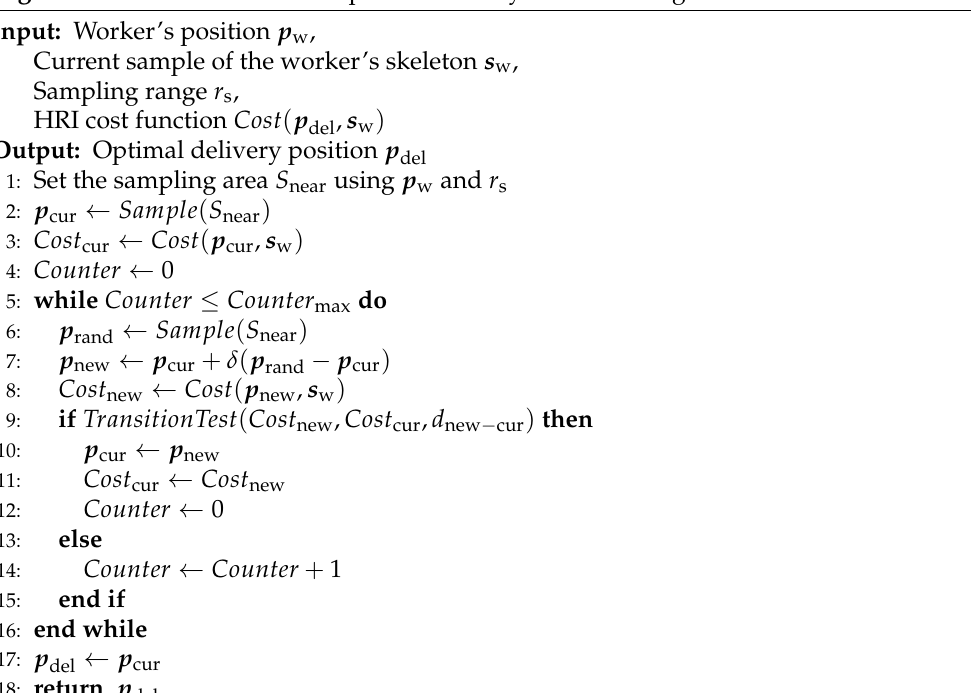
Algorithm 1 Determination of Optimal Delivery Position using